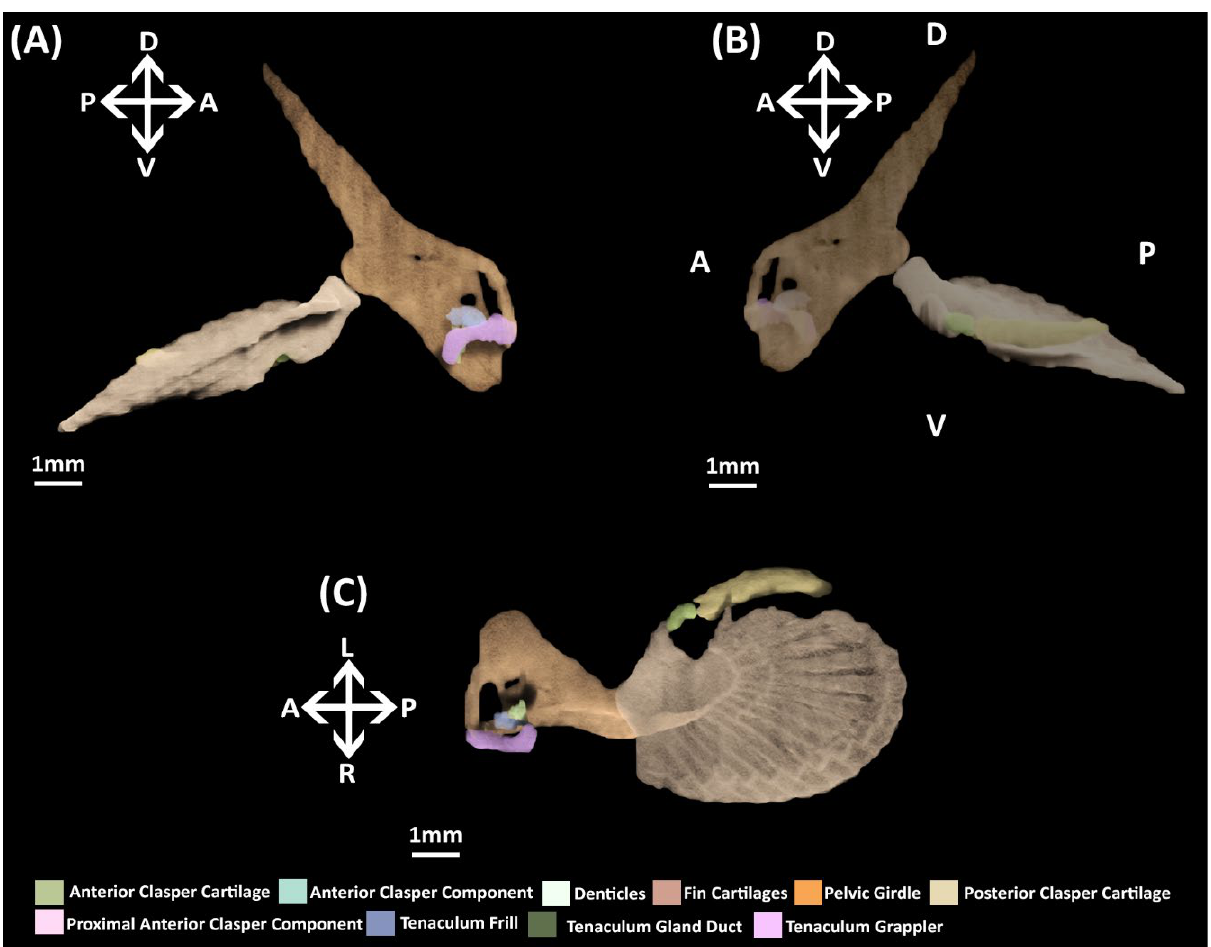
Figure 8. NanoCT models of a male stage 36 elephant shark ( Callorhinchus milii ) embryo. ( A ) Models of the pelvic skeleton from a distal lateral view; ( B ) same models from a proximal lateral view; ( C ) models from a ventral view. Anatomical orientation of models indicated by A-anterior D-dorsal P-posterior R-right L-left V-ventral.